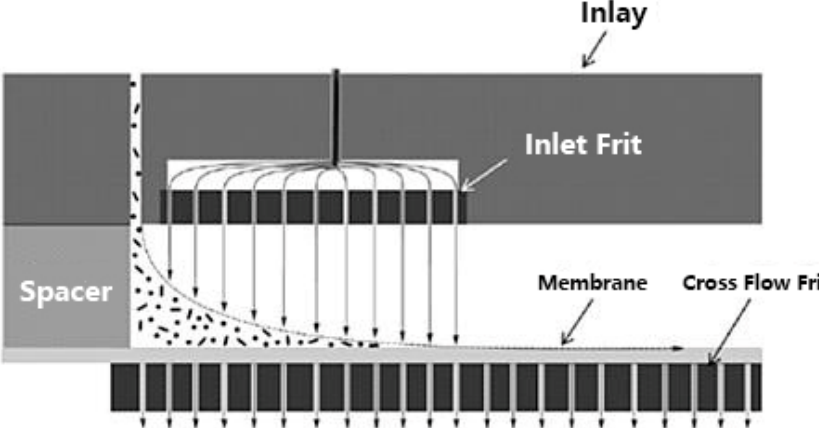
Figure 13. Hydrodynamic relaxation in frit-inlet channel asymmetrical flow field flow fractionation (by courtesy of Wyatt Technology Europe GmbH).